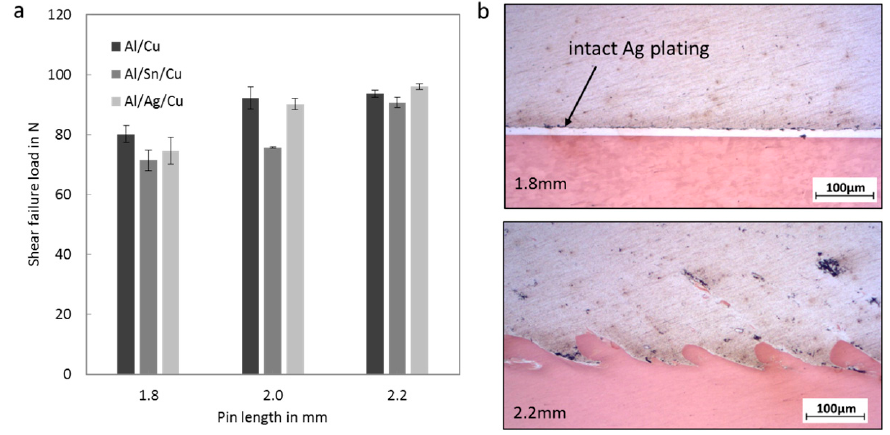
Figure 8. Influence of the plating on ( a ) the resultant failure load at 1.8 mm and 2.2 mm pin length; ( b ) detailed view on the longitudinal section of joints with Ag plated copper sheets.